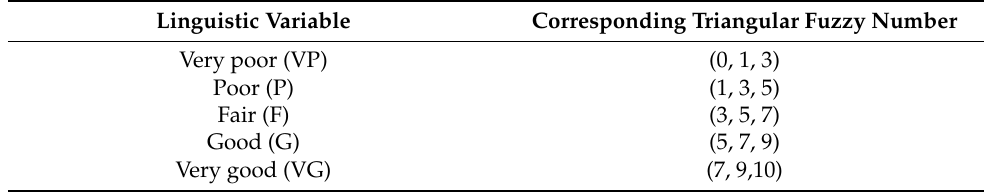
Table 3. Linguistic scales for the